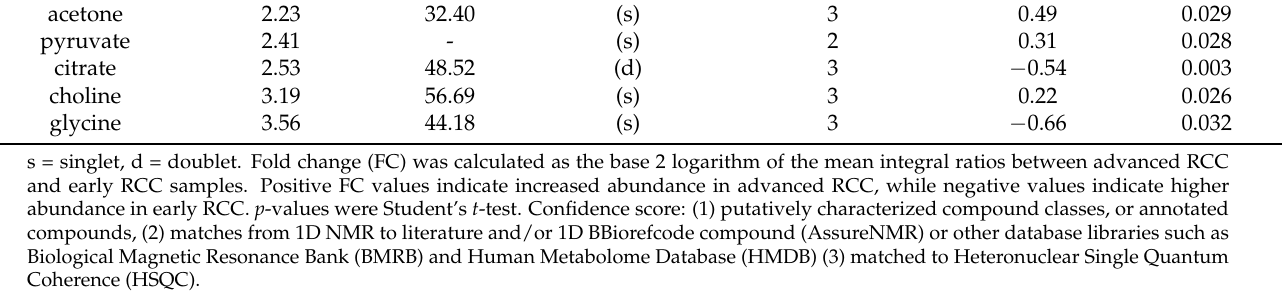
Table 4. Annotated NMR metabolites with a p -value less than 0.05. These were added to the 16-metabolite panel.